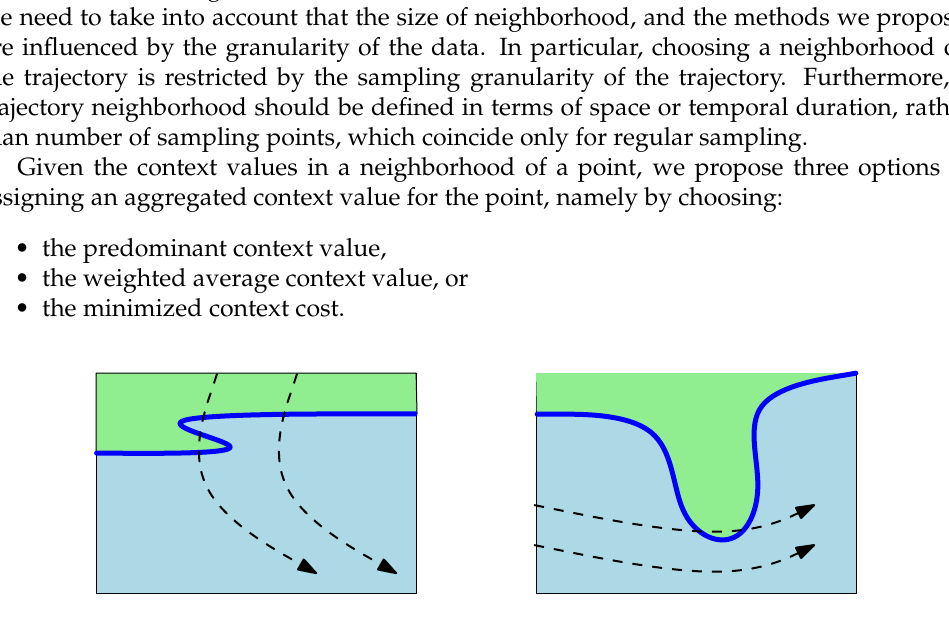
Figure 6: Trajectories (in dashed, black) over a geographic context (in bold,